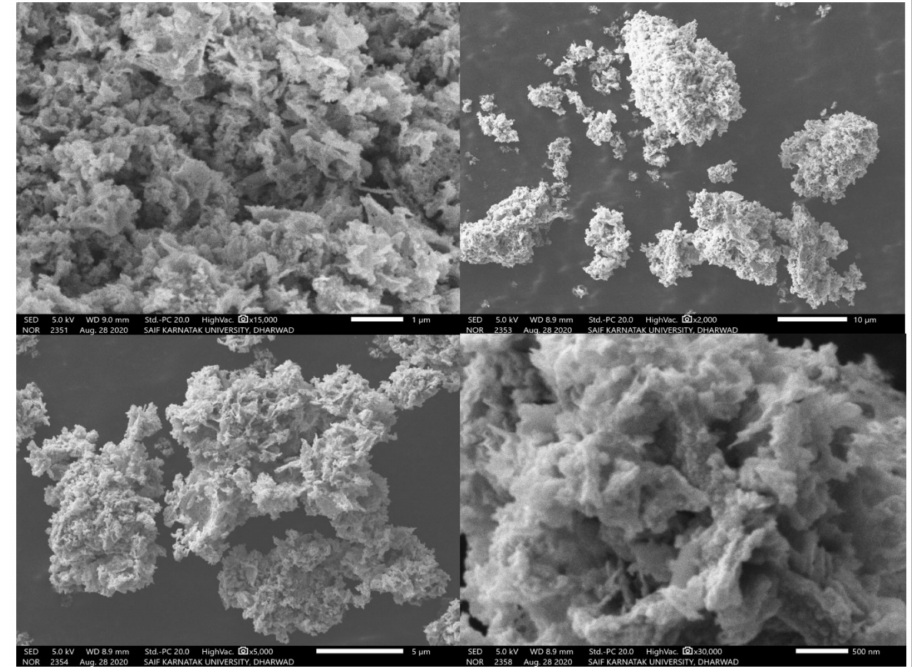
Figure 4. SEM images showing the morphology of as-prepared NiO NPs with different